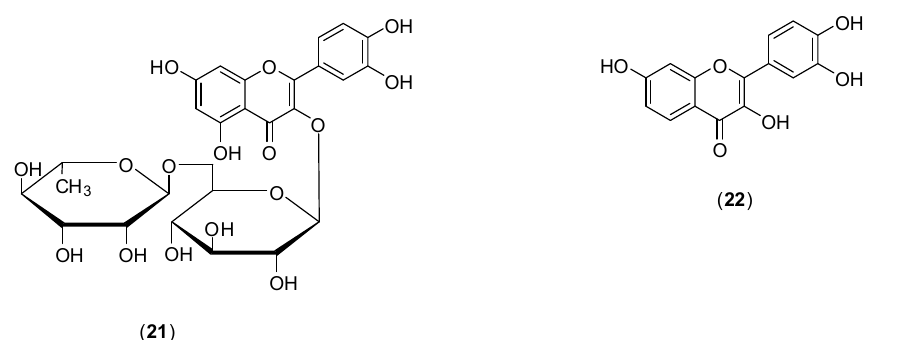
Figure 12. Structures of rutin ( 21 ) and fisetin ( 22